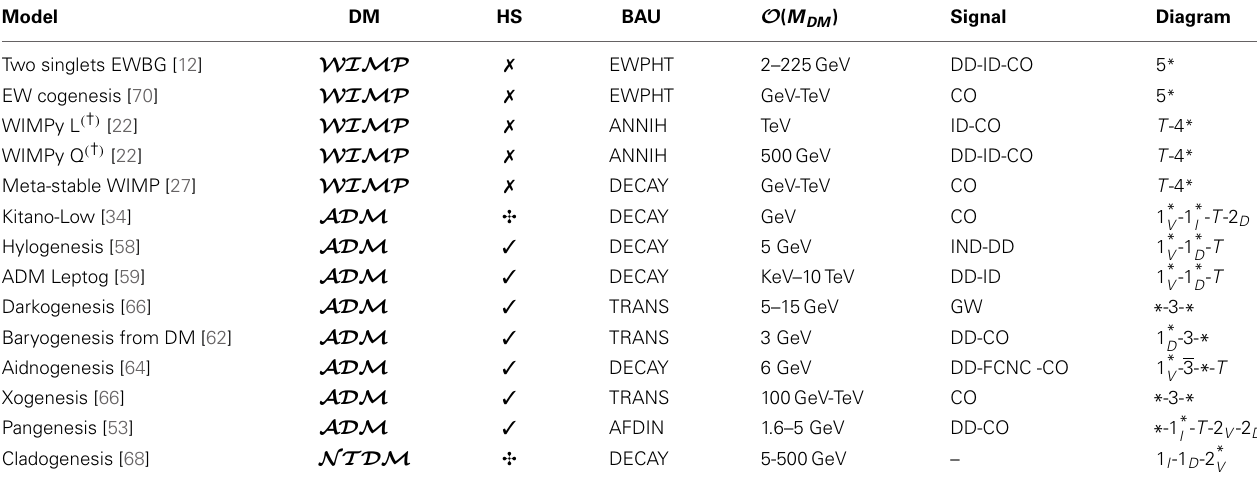
Table 1 | Summary of the models presented in this review and